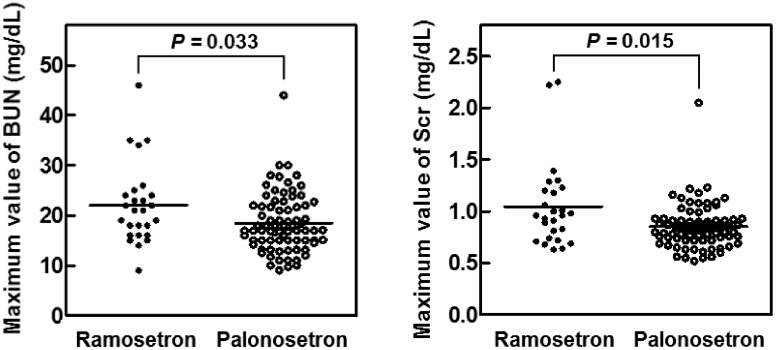
Figure 3. Maximum values of serum creatinine (Scr) and blood urea nitrogen (BUN) in patients treated for 14 days with cisplatin and either ramosetron or palonosetron. Patients with head and neck cancer ( n = 103) received cisplatin and 5-fluorouracil together with ramosetron ( n = 26) or palonosetron ( n = 77). p values determined by the Mann–Whitney U